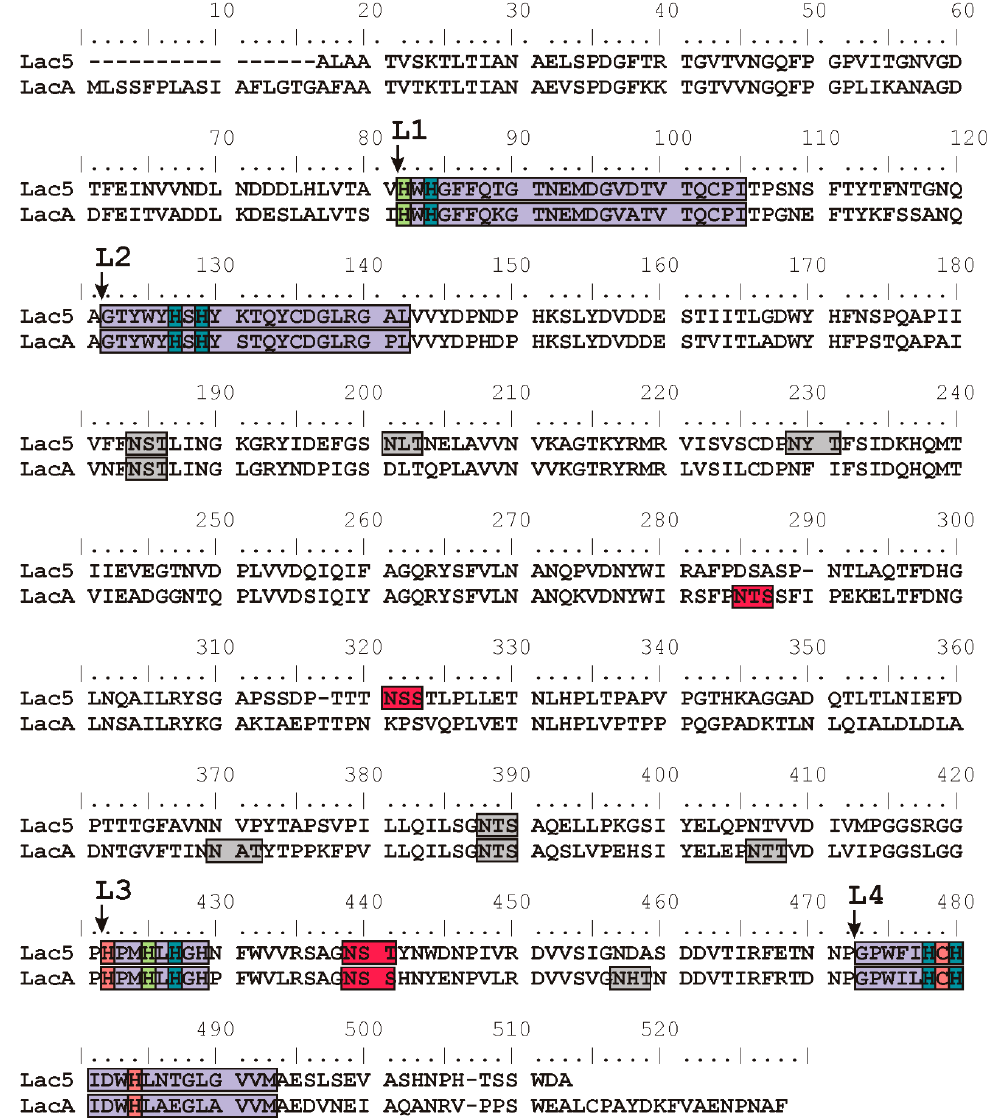
Figure 4. Alignment of the amino acid sequences of Lac5 and LacA from P. lycii . Laccase signature regions L1–L4 (according to [69]) are indicated with violet. Copper coordinating amino acid residues are indicated with coral for the T1 copper ion, leaf green for the T2 copper ion, and marine blue for the pair of T3 copper ions. Potential glycosylation sites are colored with gray and occupied glycosylation sites are colored with red.